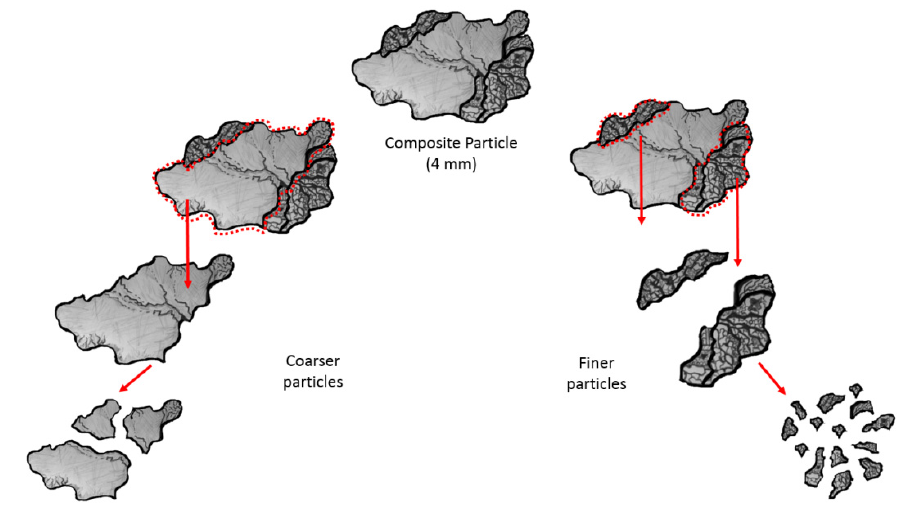
Figure 12. The fractionation of quartz (megacrysts) into course size fractions and albite and K-feldspar (matrix) into fine grain-sizes can be explained by frequent microfracture in matrix minerals.